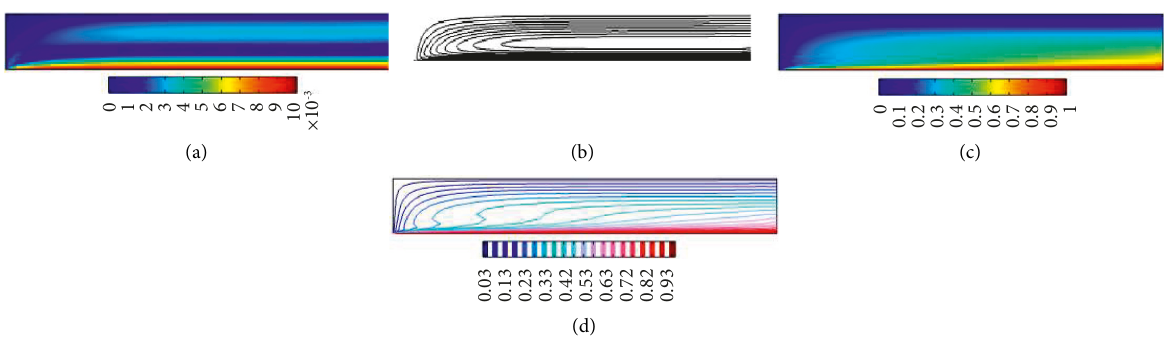
Figure 12: (a) Surface plot for velocity, (b) streamlines, (c) surface plot temperature, and (d) isothermal contours using Gr � 100 , β � 0 . 7 , Gr � 0 , U � 0 . 01. m w 0 1